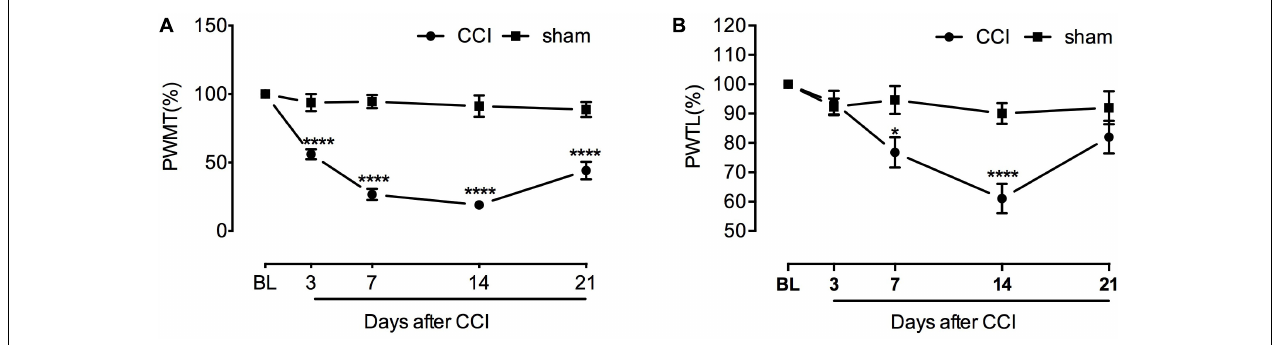
FIGURE 1 | Chronic constriction of the sciatic nerve caused mechanical and thermal hyperlagesia in rats. (A) Decreased mechanical threshold was observed at the third day after CCI and lasted to the end of behavioral testing with slight recovery ( n = 6 per group). ∗∗∗∗ P < 0.0001, significantly different compared with the sham group; CCI, chronic constriction injury; BL, baseline; PWMT, paw withdrawal mechanical threshold. (B) Increased sensitivity to heat stimulus started from the seventh day after sciatic nerve injury and remained until day 14. Thermal threshold recovered at the end of behavioral testing. ∗ p < 0.05, ∗∗∗∗ p < 0.0001, significantly different compared with the sham group; PWTL, paw withdrawal thermal latency.